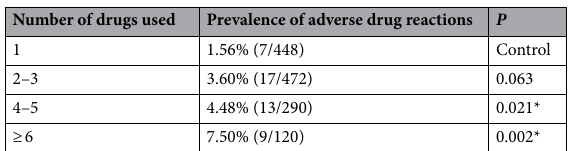
Table 3. Prevalence of adverse drug reactions with number of drugs used. Fisher’s exact test. * P < 0.05.